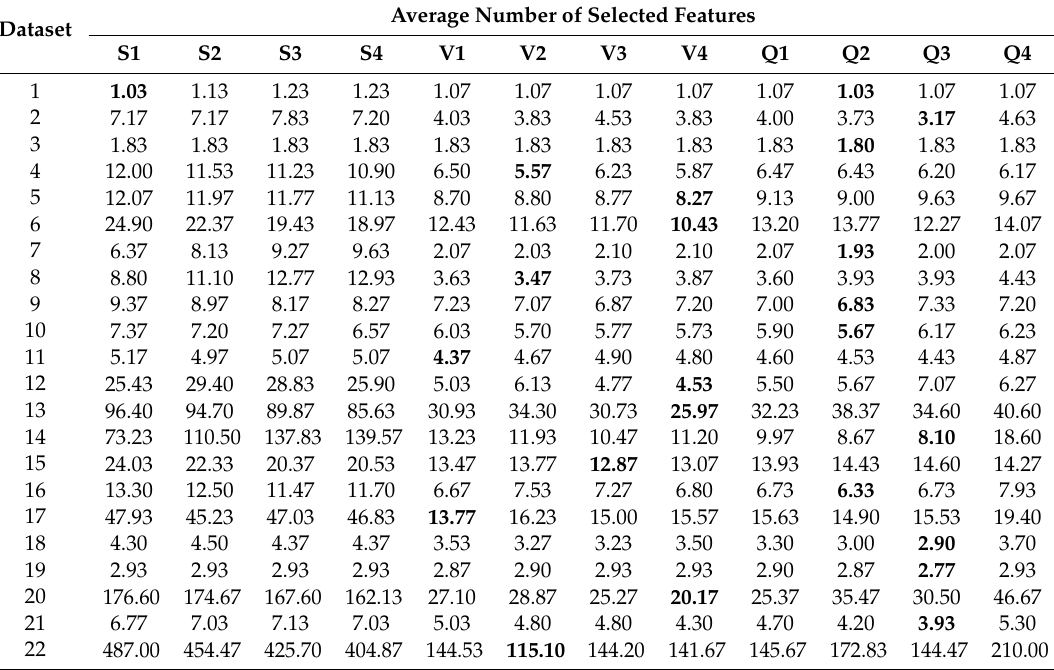
Table 8. Experimental result of the average feature size of the proposed